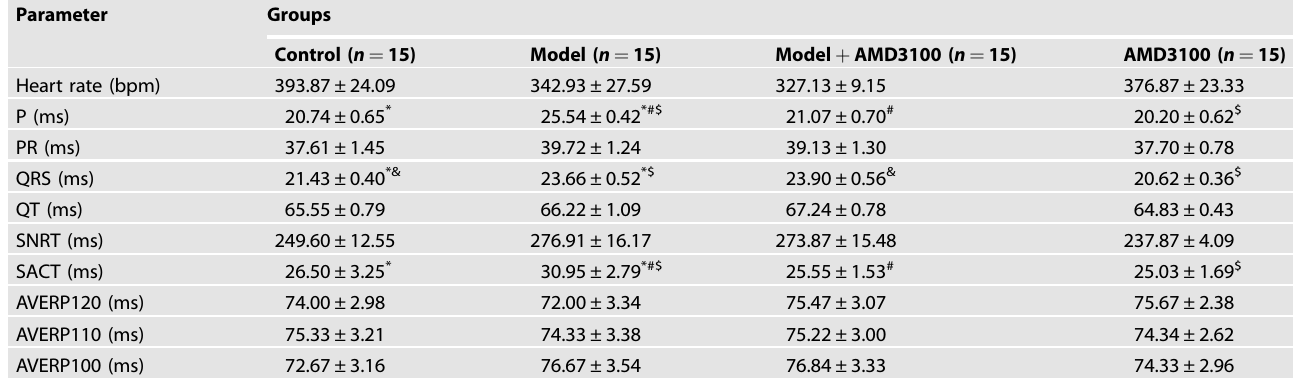
Table 1. Characterization of surface ECG parameters, transesophageal recording and atrial stimulation.